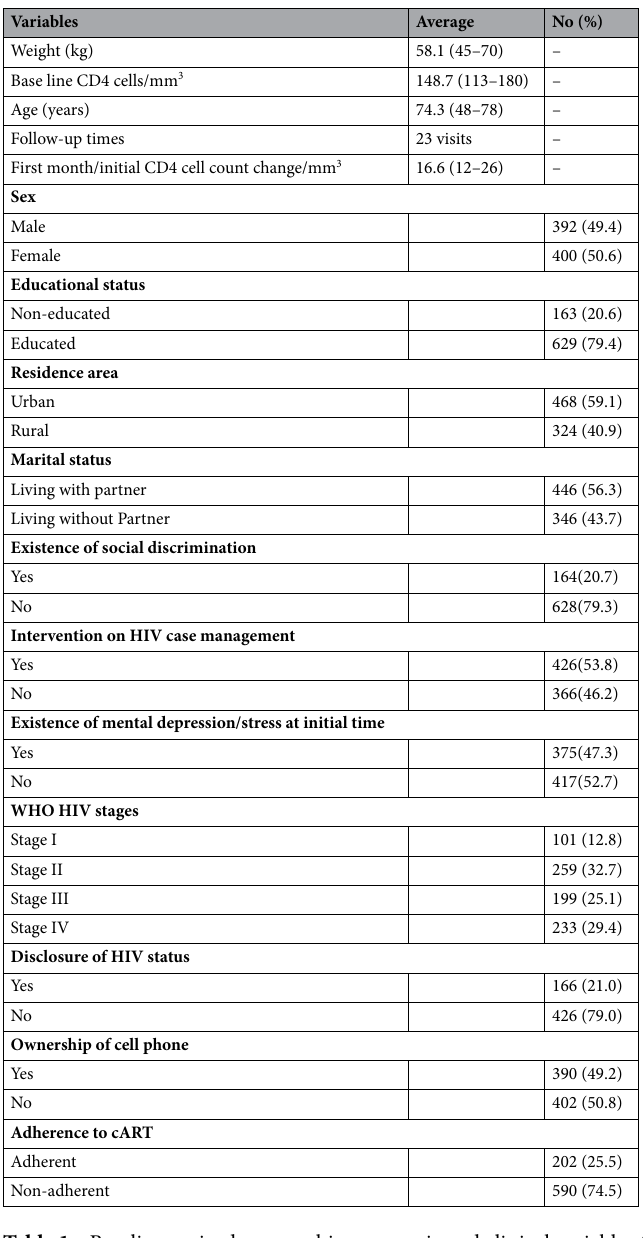
Table 1. Baseline socio-demographic, economic and clinical variables (n =